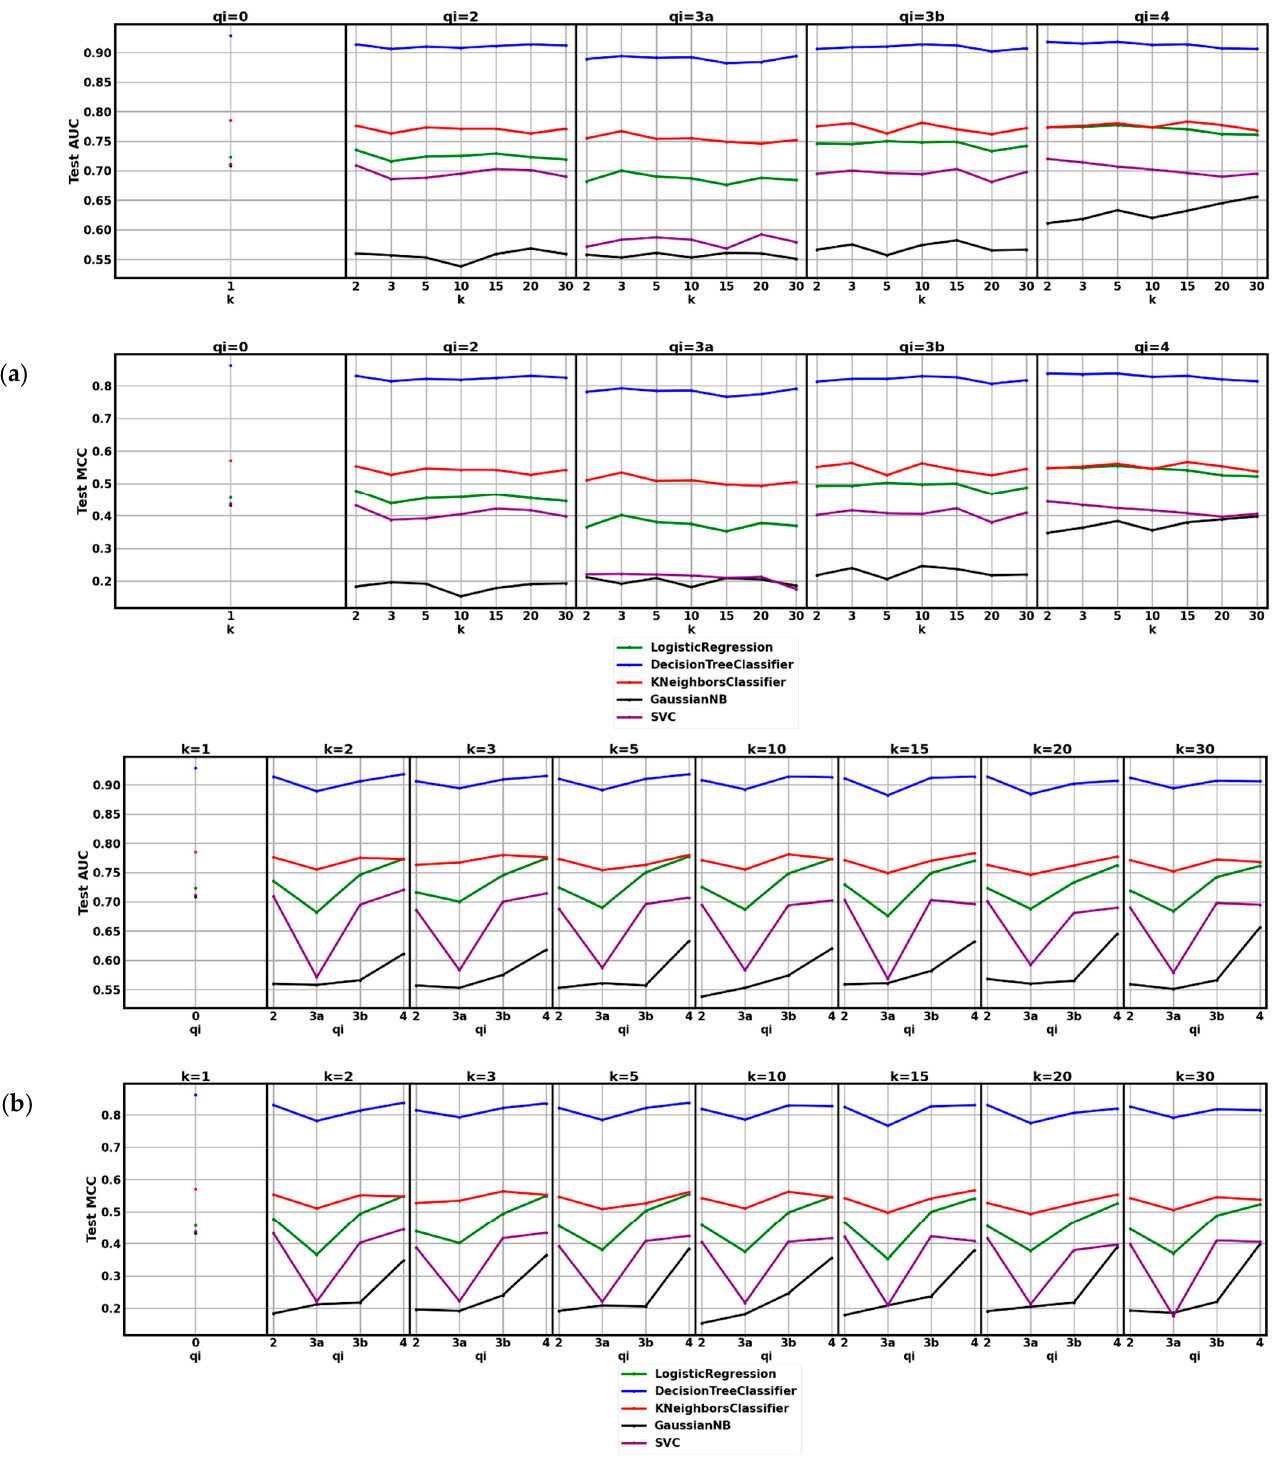
Figure 1. The results of applying five machine learning models to the dataset for various anonymization parameter combinations ( qi, k ), where qi is the code of the quasi identifier set, and k is the minimum size of the equivalence class (Table 2). ( a ) The area under the curve ( AUC ) score results (first row) and the Matthews correlation coefficient ( MCC ) score results (second row) for the test set plotted against k for each qi value. ( b ) The AUC score results (first row) and the Matthews correlation coefficient ( MCC ) score results (second row) for the test set plotted against qi for each k value. In Figure 1, the horizontal axis contains all of the qi, k value combinations, where qi is the ID of the quasi identifier set as presented in Table 2. In Figure 1a, the AUC and MCC scores for the test dataset are plotted against k for each of the qi values, while Figure 1b depicts AUC and MCC plotted against qi for each of the k values. The parameters qi = 0, k = 1 represent the case in which the machine learning models were applied to the non- anonymized dataset. It can be observed that most machine learning models had better AUC, MCC scores with the non-anonymized dataset, which means that the information loss occurring from the anonymization process in general reduced the predictive ability of the models. However, the five models were affected to various degrees, with Gaussian naive Bayes suffering the most prominent performance reduction, the decision tree and KNN classifiers showing the most stable performance across the different anonymization parameter values, and logistic regression presenting a performance improvement as a re- sult of the anonymization process for qi = 3b, 4. In Figure 2, the AUC score and the MCC score are plotted juxtaposed with the GIL value against the anonymization parameter values, separately for each tested model. Fig- ure 2a depicts AUC, MCC and GIL plotted against k for each qi value separately, while Figure 2b depicts AUC, MCC and GIL plotted against qi for each k value. It can be observed that lower GIL values were associated with higher AUC, MCC values in the cases of the logistic regression and Gaussian naive Bayes models. On the other hand, the decision tree, the KNN and the SVM classifiers were less affected by the variation in the GIL values. The demonstrated results indicate that for a specific qi value, the k value did not affect the performance of the tested machine learning models significantly. Contrarily, all five models demonstrated lower performance for qi = 3a, which corresponded to the QI attrib- utes (AGE, SEX, OUTCOME). However, the performance of most models was noticeably